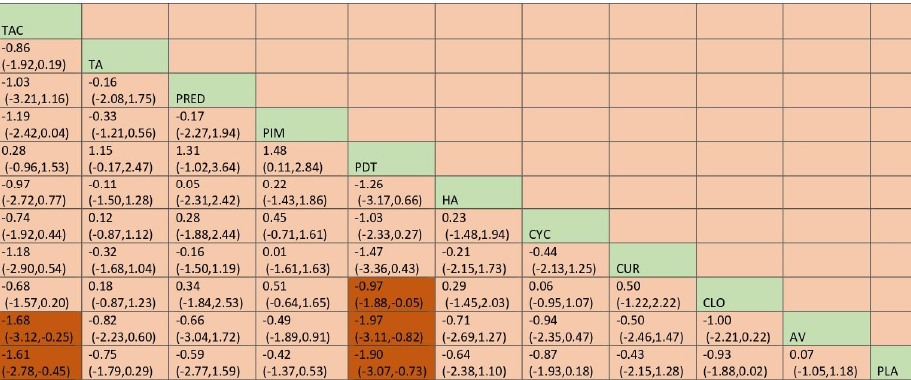
Figure 23. League table: Pain Score (subgroup analysis). Abbreviations: AML, amlexanox paste; AV, aloe vera; CUR, curcumin gel; PDT, photodynamic therapy; PLA, placebo; TAC, tacrolimus; FLU, flucinonide acetonide; CLO, clobetasol propionate; PIM, pimecrolimus; TA, triamcinolone acetonide; CYC, cyclosporine; PRED, prednisolone; HA, hyaluronic acid. The green highlights indicate the interventions and the dark highlights indicate the significant results.